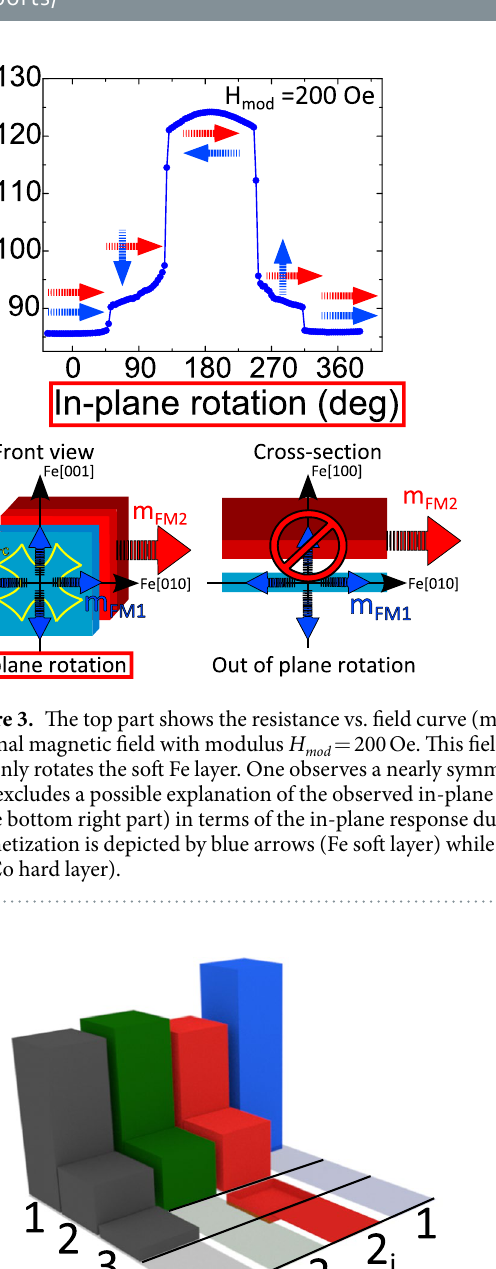
which allow the different PMA variation in steps of a half lattice period a /2 (an Fe atomic layer). The model M 2 i with an oscillatory decay of PMA inside Fe is the closest to the numerical predictions for the MgO/Fe/MgO case 12 .